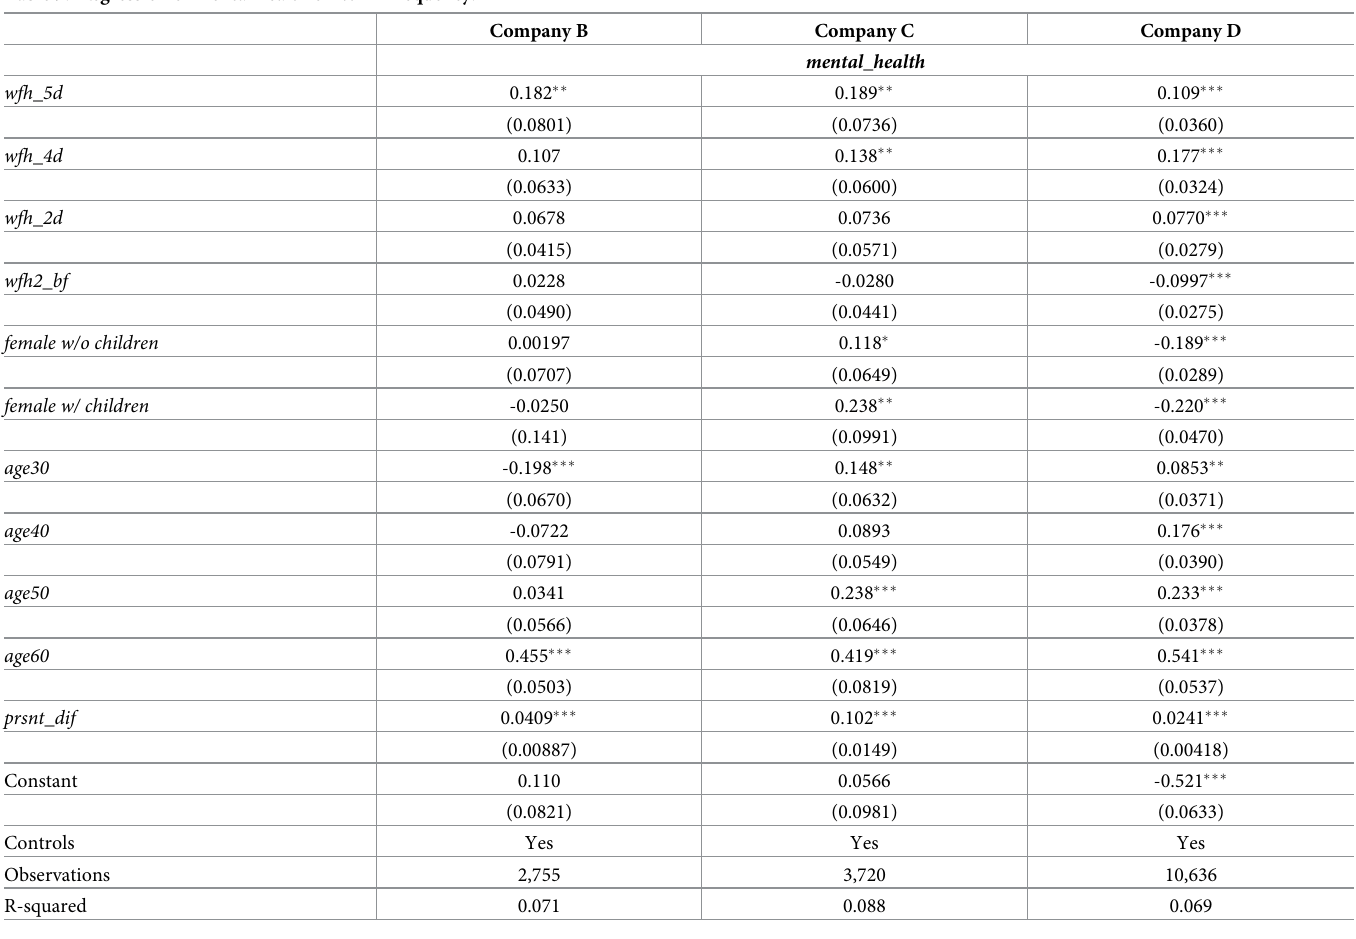
Table 9. Regression of mental health on WFH